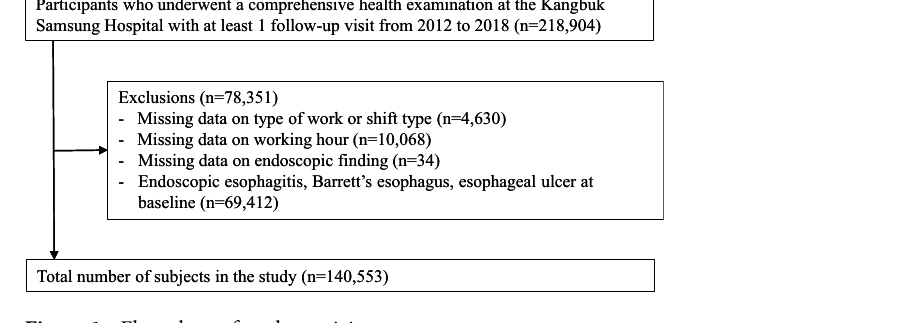
Figure 1. Flow chart of study